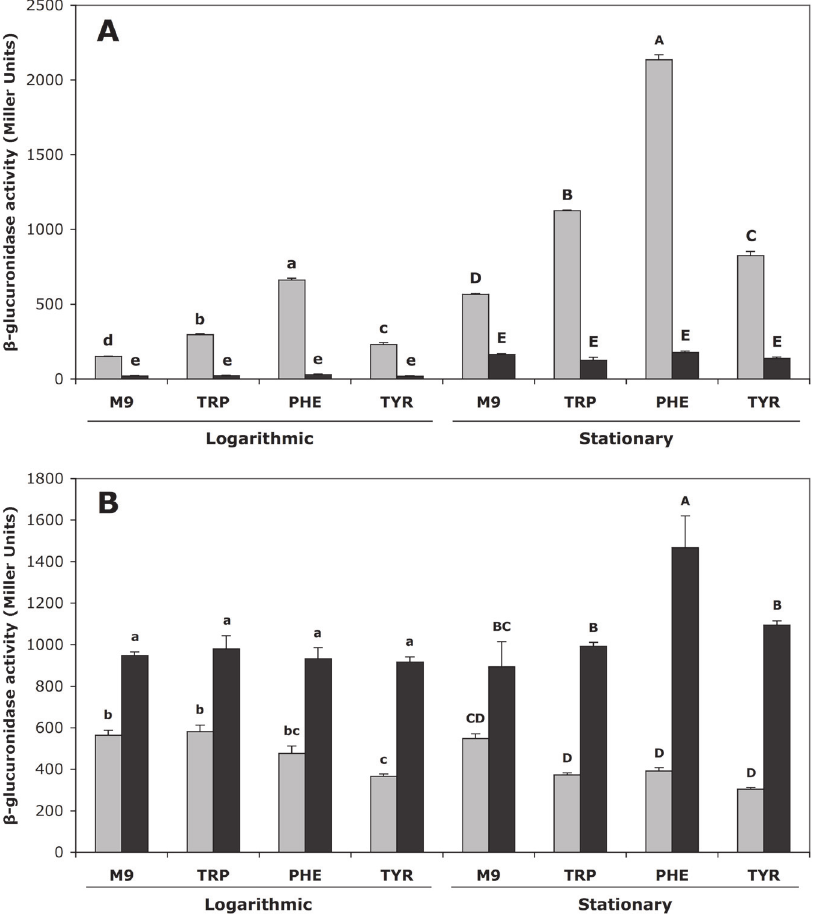
Fig 2. The expression of akr and ipdC is modulated by TyrR. Expression from (A) ipdC and (B) akr in the presence or absence of aromatic amino acids in wild-type E . cloacae UW5 (grey) and tyrR null mutant E . cloacae J35 (black). Cells were assayed for β -glucuronidase activity in both logarithmic and stationary phases of growth. Error bars represent the standard error of the means of three independent replicates. Statistically significant differences of p < 0.05 are indicated by lowercase letters in logarithmic phase, and uppercase letters in stationary phase.